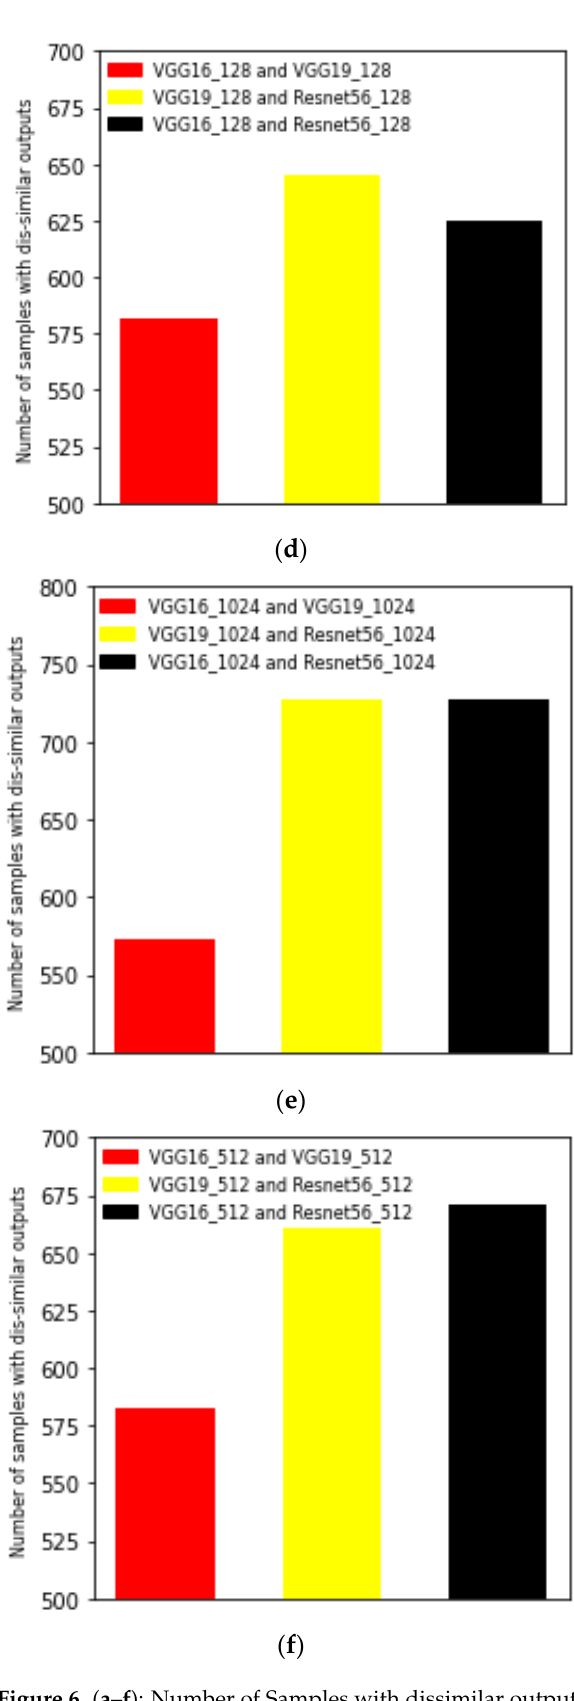
Figure 6. ( a – f ): Number of Samples with dissimilar outputs As already discussed, the requirement for the decision-fusion to produce better results is that the models that are to be fused should make dissimilar predictions on a number of test samples. In addition, from the above graphs, it is clear that there is a